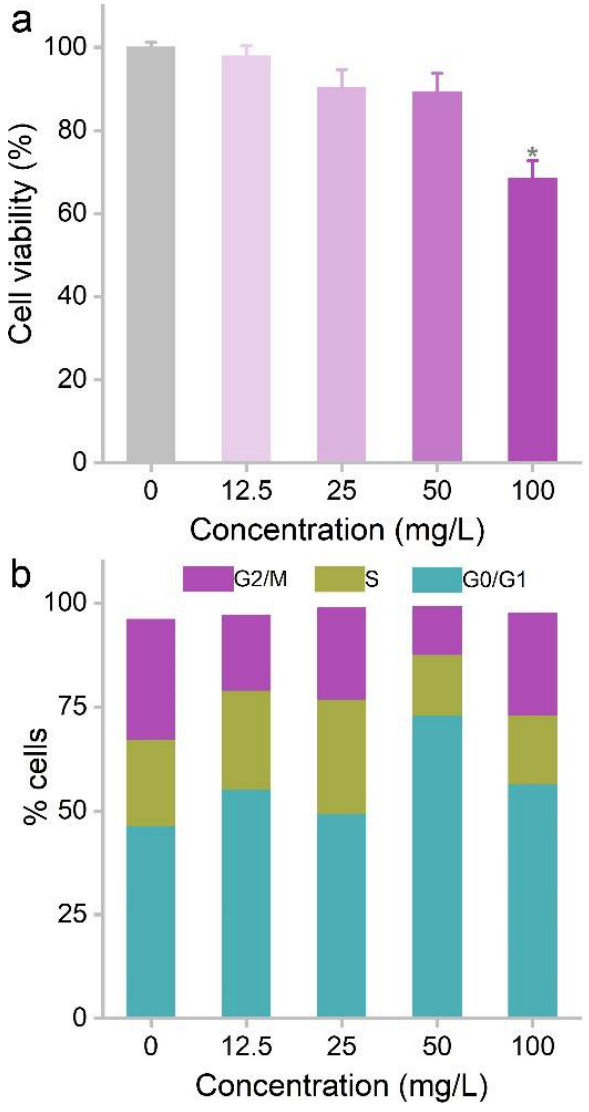
Figure 2. Influence of MOF-74(Co) NPs on the cell viability ( n = 4) ( a ) and cell cycle ( b ) of LO2 cells. * p < 0.05 compared to the control group.